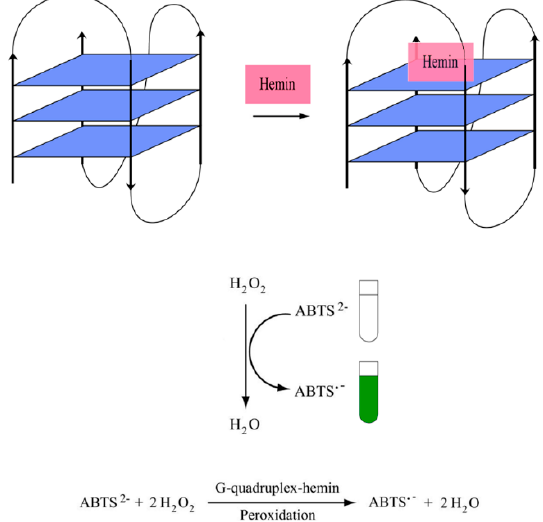
Figure 9. A schematic illustration of simple colorimetric G-quadruplex DNAzyme system.